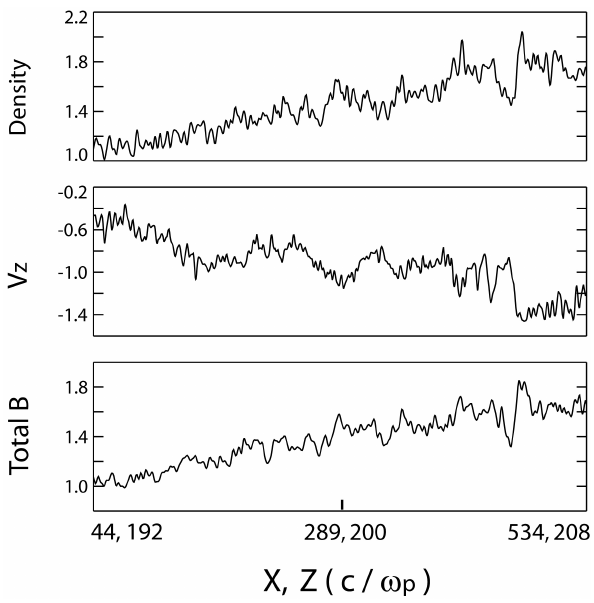
Fig. 3. Densities, magnetic field strengths, and the north/south com- ponent of the velocity along the radial dashed line shown in Fig. 1. Densities and magnetic field strengths decrease with distance up- stream from the bow shock, while flows are deflected